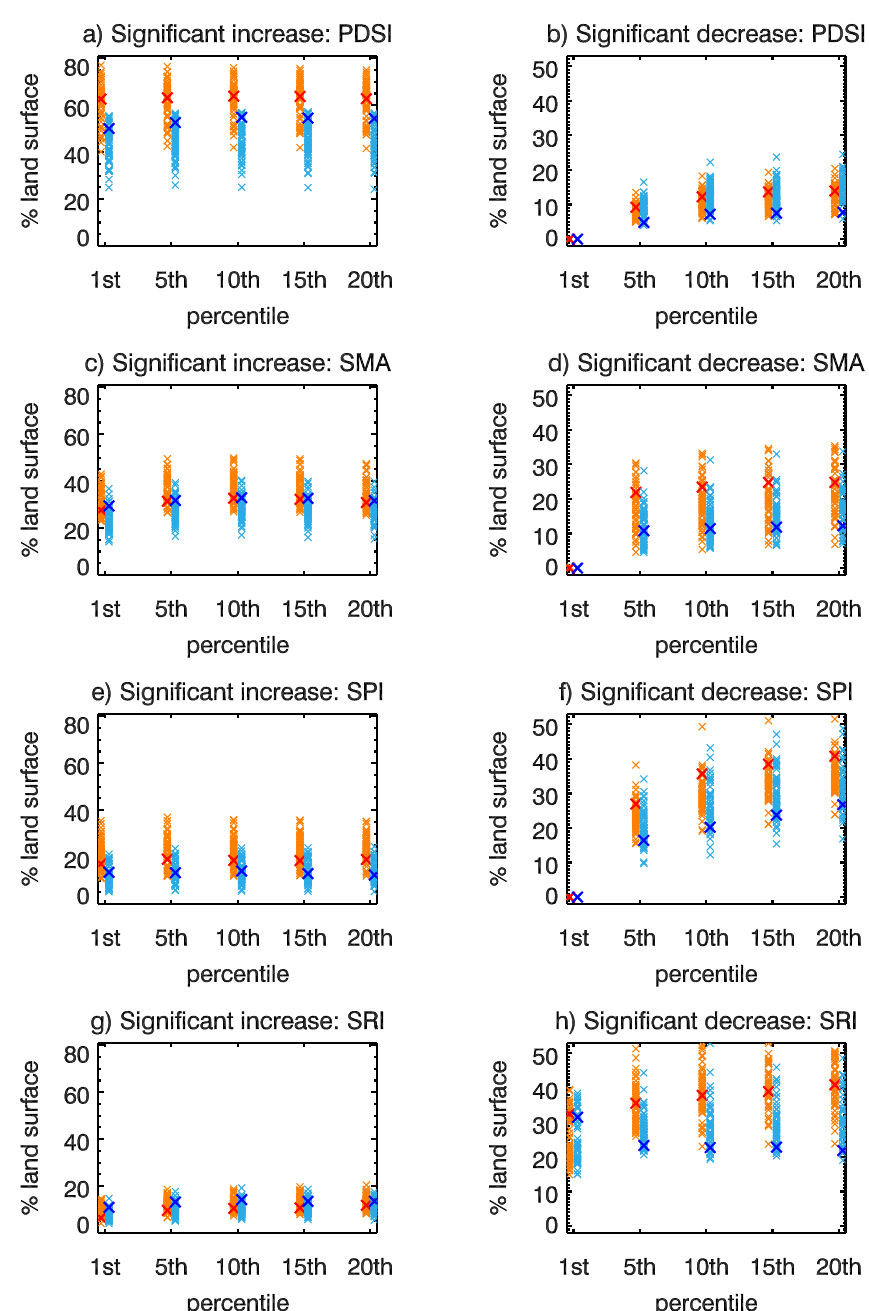
Fig. 7. The percent of the land surface (non-cold areas) with significant changes (as defined in Sect. 3.1) in the time spent in drought in the 2080s (2070–2099) as given by the ESE (increases – left column, and decreases – right column) for the four drought indices SPI: (a) , (b) ; SMA: (c) , (d) ; PDSI: (e) , (f) and SRI: (g) and (h) as a function of drought threshold. The A1B future scenario is shown in orange and RCP2.6 shown in blue. The crosses represent individual model responses with the exemplar ensemble member marked larger symbols in red (A1B) and dark blue